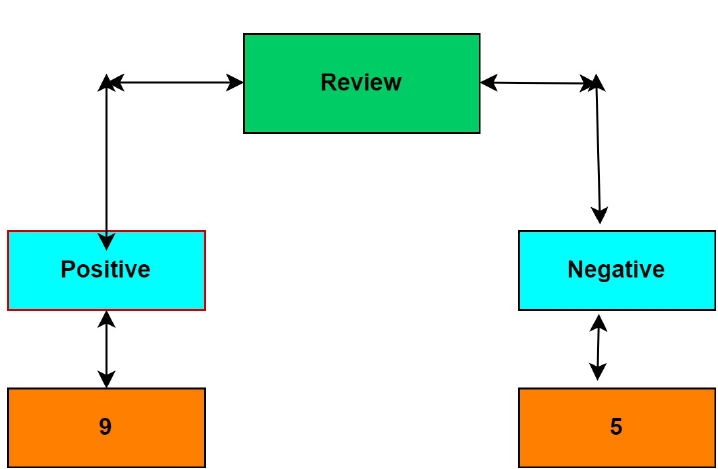
Figure 8. Polarity vs. frequency.